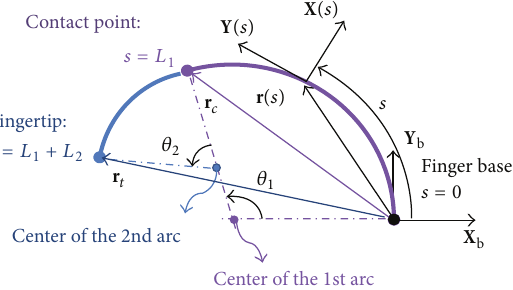
Figure 4: Kinematics variables of the